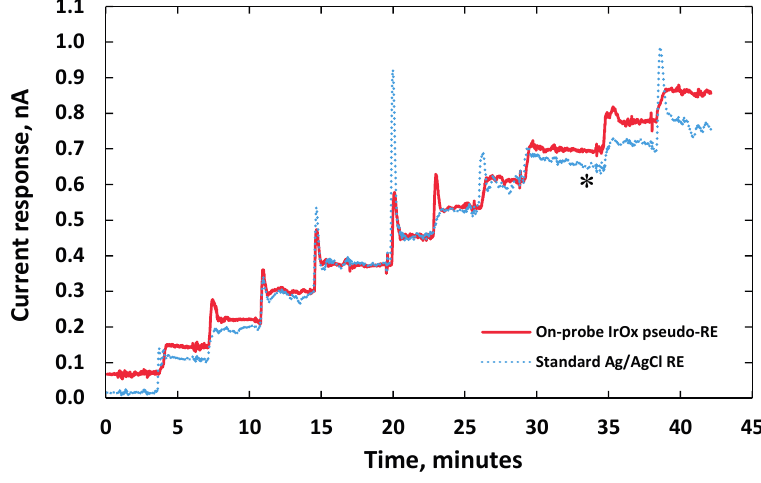
Figure 9. Current responses of two DA sensors for incremental additions of 2.5 μ M dopamine to 40 mL of 0.05-M PBS solution: (red) the integrated DA sensor had an IrO x WE and an IrO x pseudo-RE on the same probe; and (blue) the other DA sensor had a gold WE with an external standard AgCl/Ag RE